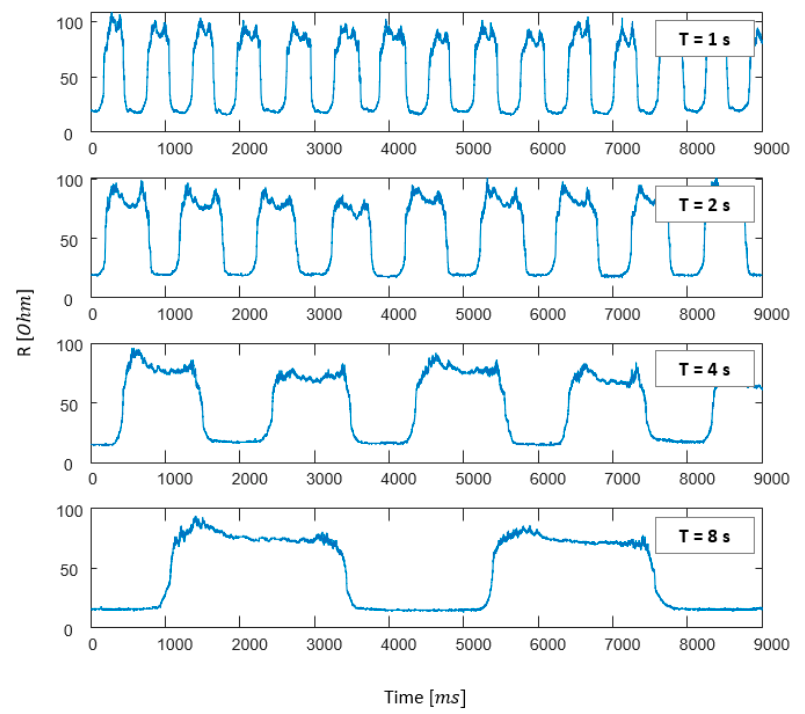
Figure 9. Repeated measurement results of the wrist movement with different speed conditions, where top graph shows 2 Hz (fast) flexion/extension, second 1 Hz, third 0.5 Hz, and bottom 0.25 Hz (slow), and ms stands for milliseconds.